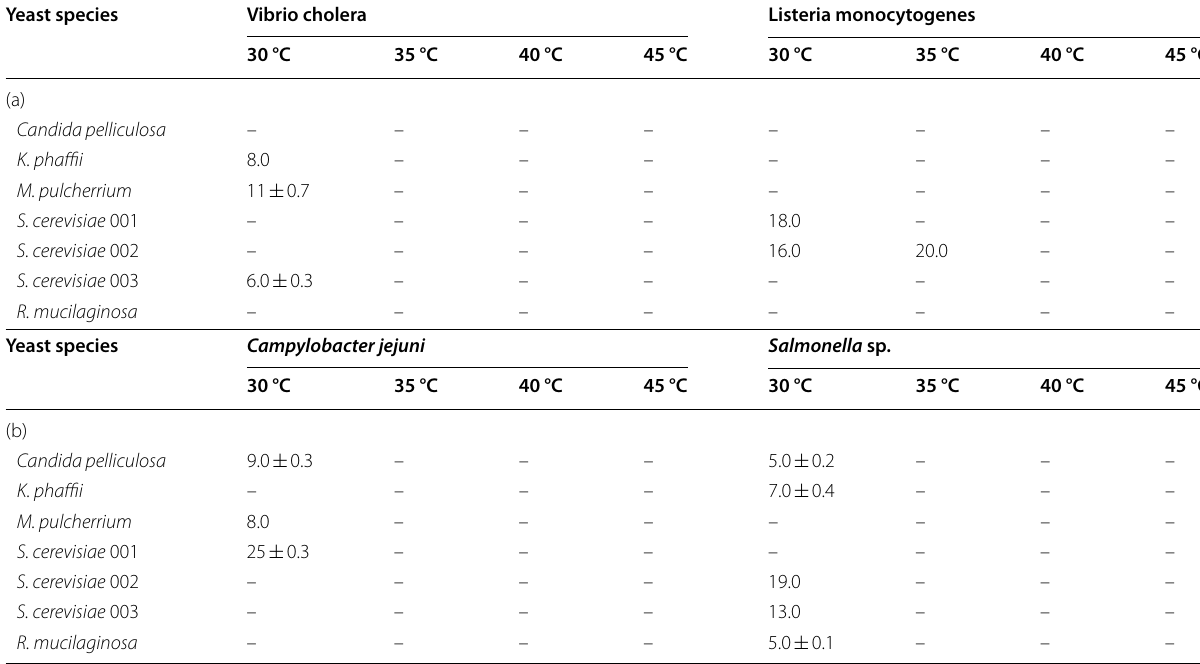
Table 5 Effect of temperature on the microbial inhibitory activity (mm) of the yeast species